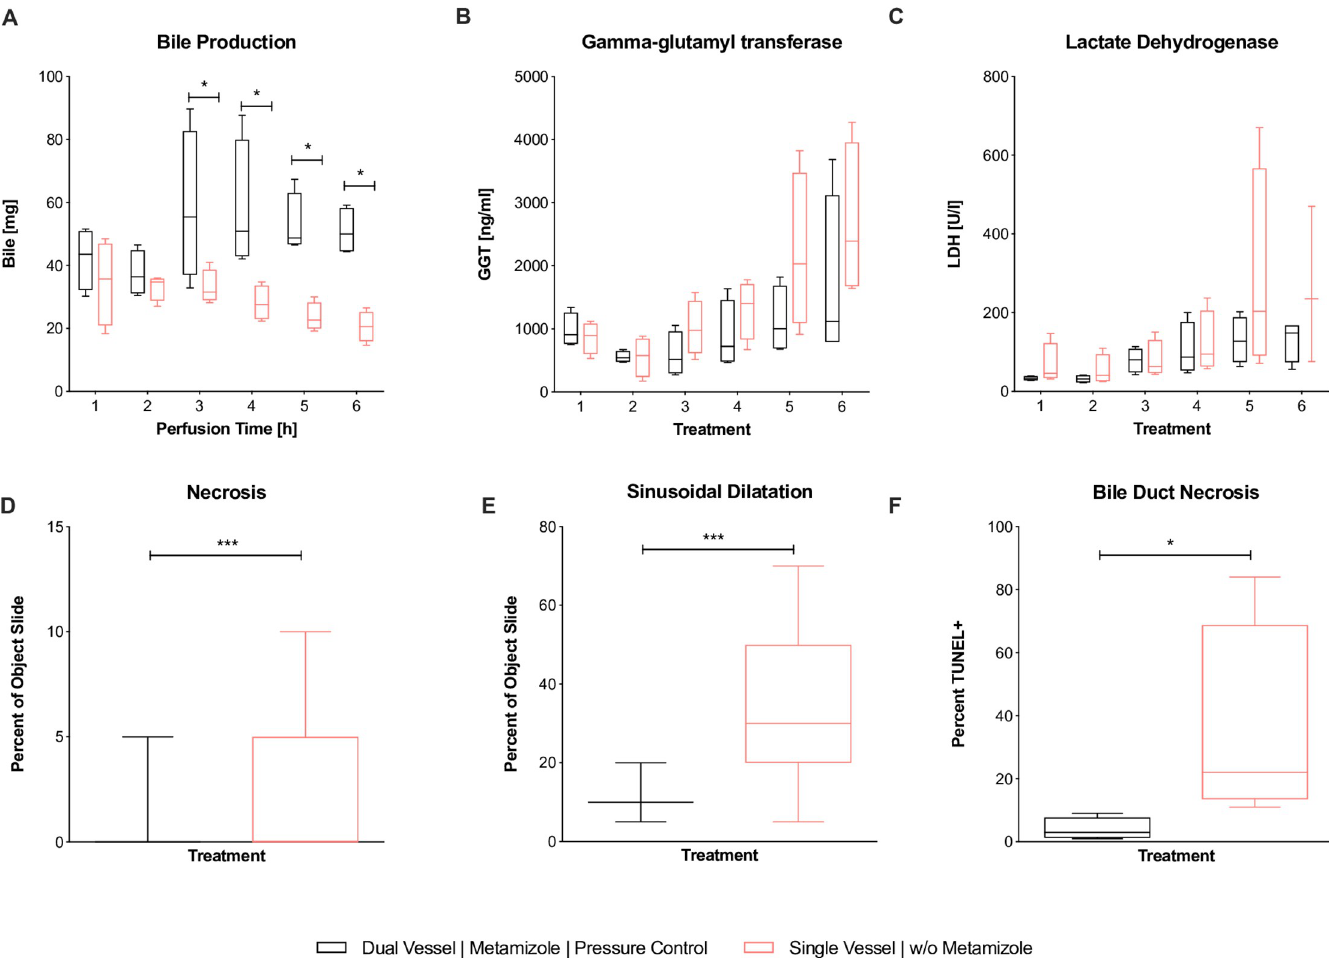
Fig 6. Comparison of dNEVLP MP and sNEVLP groups 2. Comparison of dNEVLP MP and sNEVLP: (A) amount of bile production, (B) gamma-glutamyl transferase within bile, (C) lactate dehydrogenase within bile, (D) liver parenchyma necrosis, (E) liver parenchyma sinusoidal dilatation, (F) bile duct necrosis in TUNEL staining. � indicates p � 0.05 and ��� p = 0.001. Data shown as median and interquartile range.